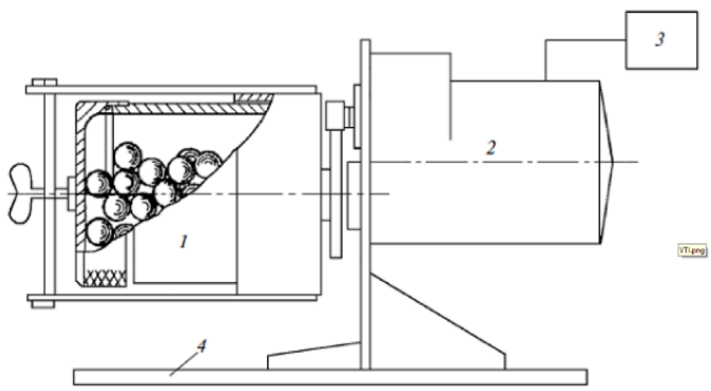
Figure 2. Schematic of a tubular mill, 1—drum, 2—electric engine, 3—control unit, 4—pedestal.